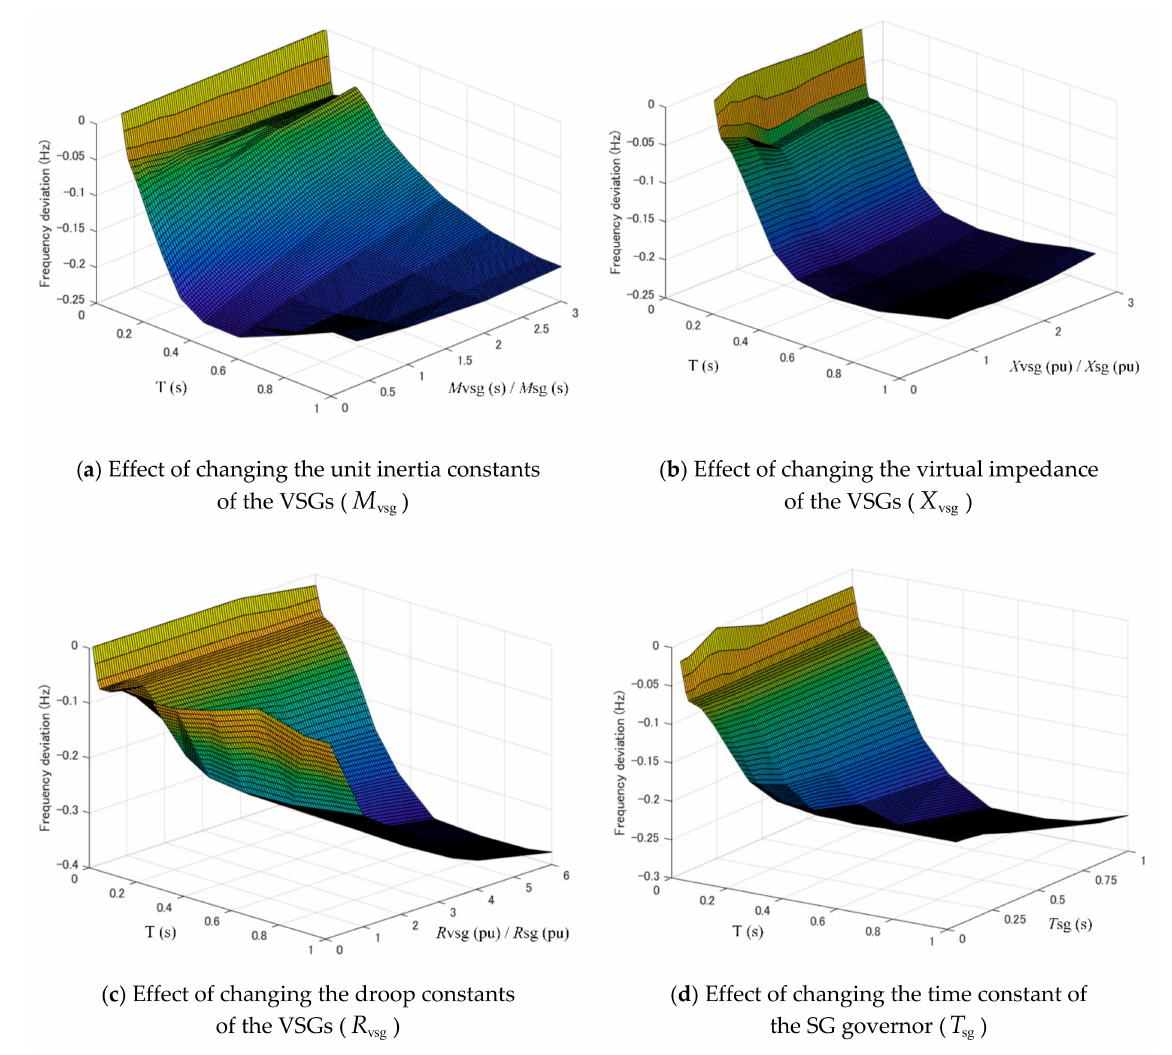
Figure 10. Variation in the frequency deviation of the center of inertia of the system for various generator